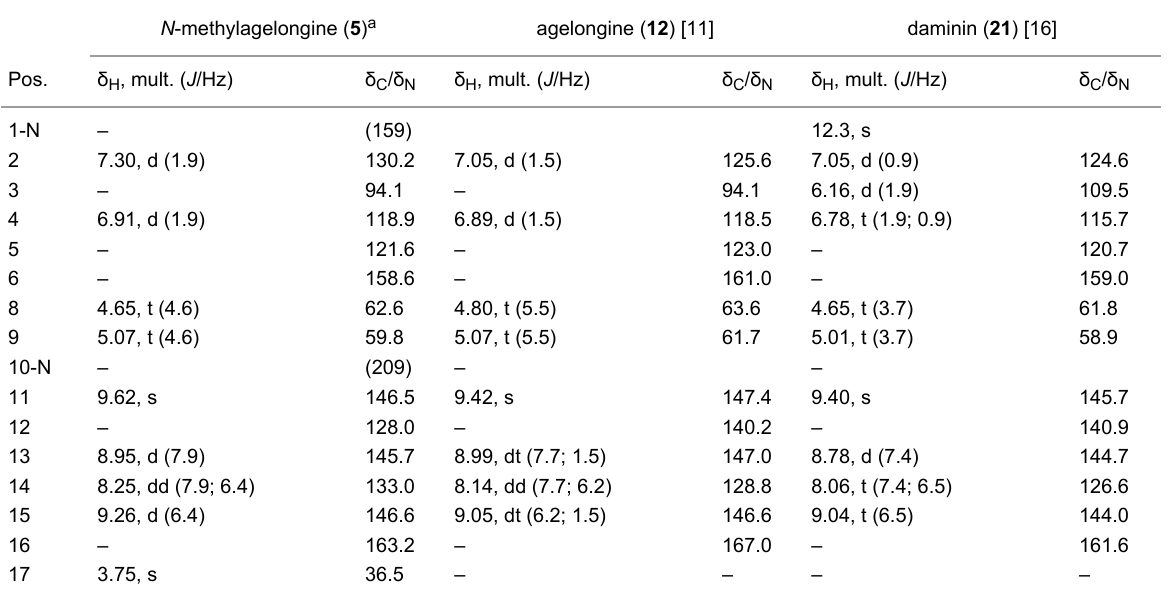
Table 3: 1 H, 13 C, and 15 N chemical shifts of N -methylagelongine ( 5 ) (600 MHz, DMSO- d 6 ) in comparison to agelongine ( 12 ) (500 MHz, MeOH- d 4 ) and daminin ( 21 ) (400 and 500 MHz, DMSO- d 6 ).